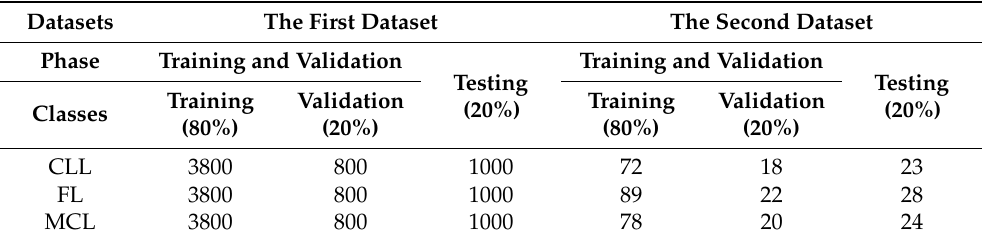
Table 1. Distribution of the two histological datasets of malignant lymphomas. Datasets